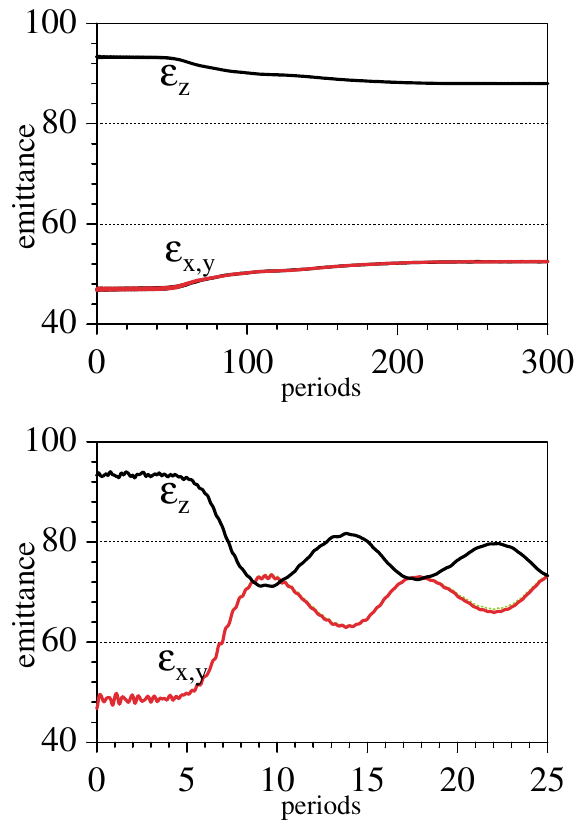
(cid:3) 2 =(cid:19) z x